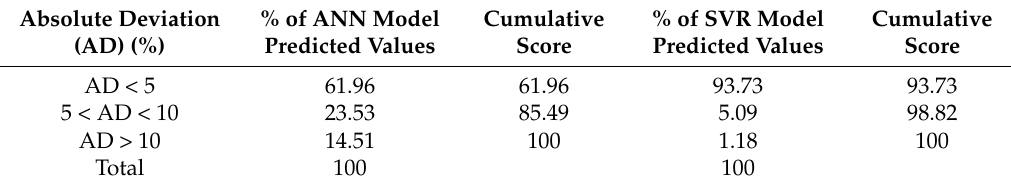
Table 6. Percentage of predicted data points for the heat transfer coefficient of R600a via the ANN-based and SVR-based model in terms of absolute deviation (AD) for the training dataset.